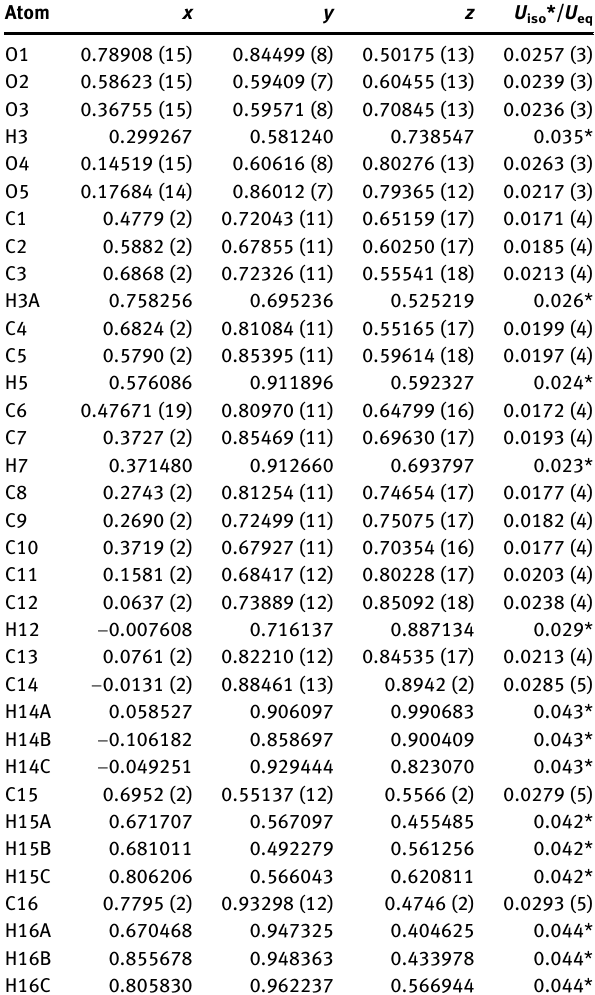
Table  : Fractional atomic coordinates and isotropic or equivalent isotropic displacement parameters (Å 